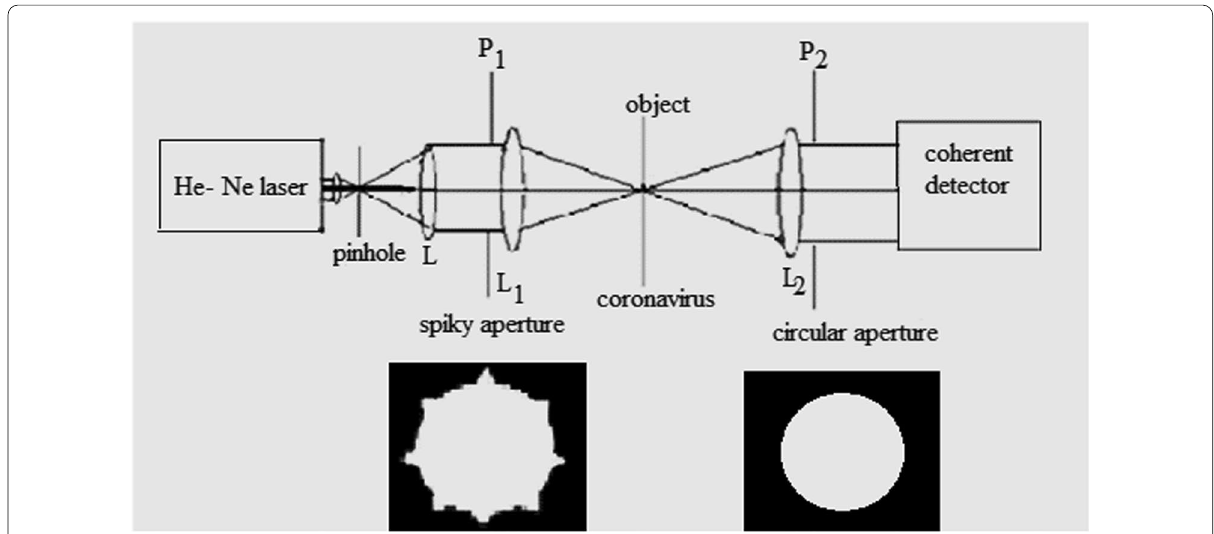
Fig. 1 Set-up for the confocal scanning laser microscope provided with illumination spiky aperture P 1 and detection uniform circular aperture P 2 . The He-Ne laser made parallel beam using spatial filter composed with adequate pinhole and collimating lens L. The object is mechanically scanned with the electronic scanning of the detector to construct the